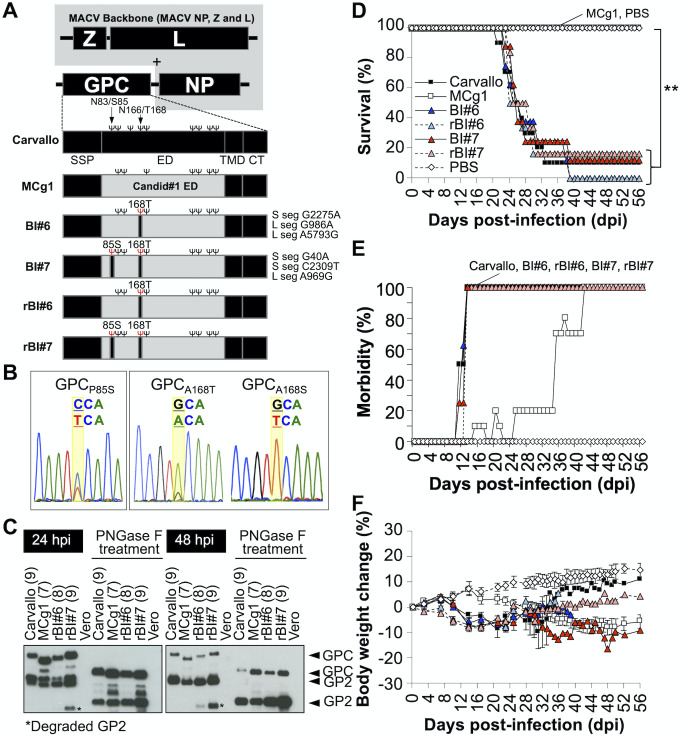
MACV Carvallo strain expressing Cd#1-GPC ectodomain with reversions.(A) Schematic representation of the genome of MCg1 and its revertants. BI#6 and BI#7 have synonymous substitutions as described on the right side of the GPC schematic. Ψ in black character represents an N-glycosylation site. Ψ in red character indicates an N-glycosylation site obtained by reversion. SSP: stable signal peptide, ED: ectodomain, TMD: transmembrane domain, CT: cytoplasmic tail. (B) Representative sequence chromatograms at reverted sites on GPC of MCg1 recovered from brain of MCg1-infected mice. (C) The presence of N-glycosylations on GPC was validated by WB. Vero cells were infected with each virus at MOI = 1. Cell lysates were treated with PNGaseF to remove N-linked glycosylations. Number of putative N-glycosylation sites was indicated in parentheses. (D) Survival rate of the IFN-αβ/γ R-/- mice after infections (Carvallo N = 10, MCg1 N = 10, BI#6 N = 8, rBI#6 N = 6, BI#7 N = 8, rBI#7 N = 6, PBS N = 6). Statistically significant differences are indicated by asterisks (**, P<0.01 by log rank test). (E) Morbidity rate of the IFN-αβ/γ R-/- mice after infections. Scruffy coats, hunched posture, lethargy, imbalance, partial paralysis, not active and death were counted as a sign of disease. (F) Body weight changes were monitored on the indicated days. Error bars indicate the SEM. The data shown are pooled from two independent experiments except rBI#6 and rBI#7.